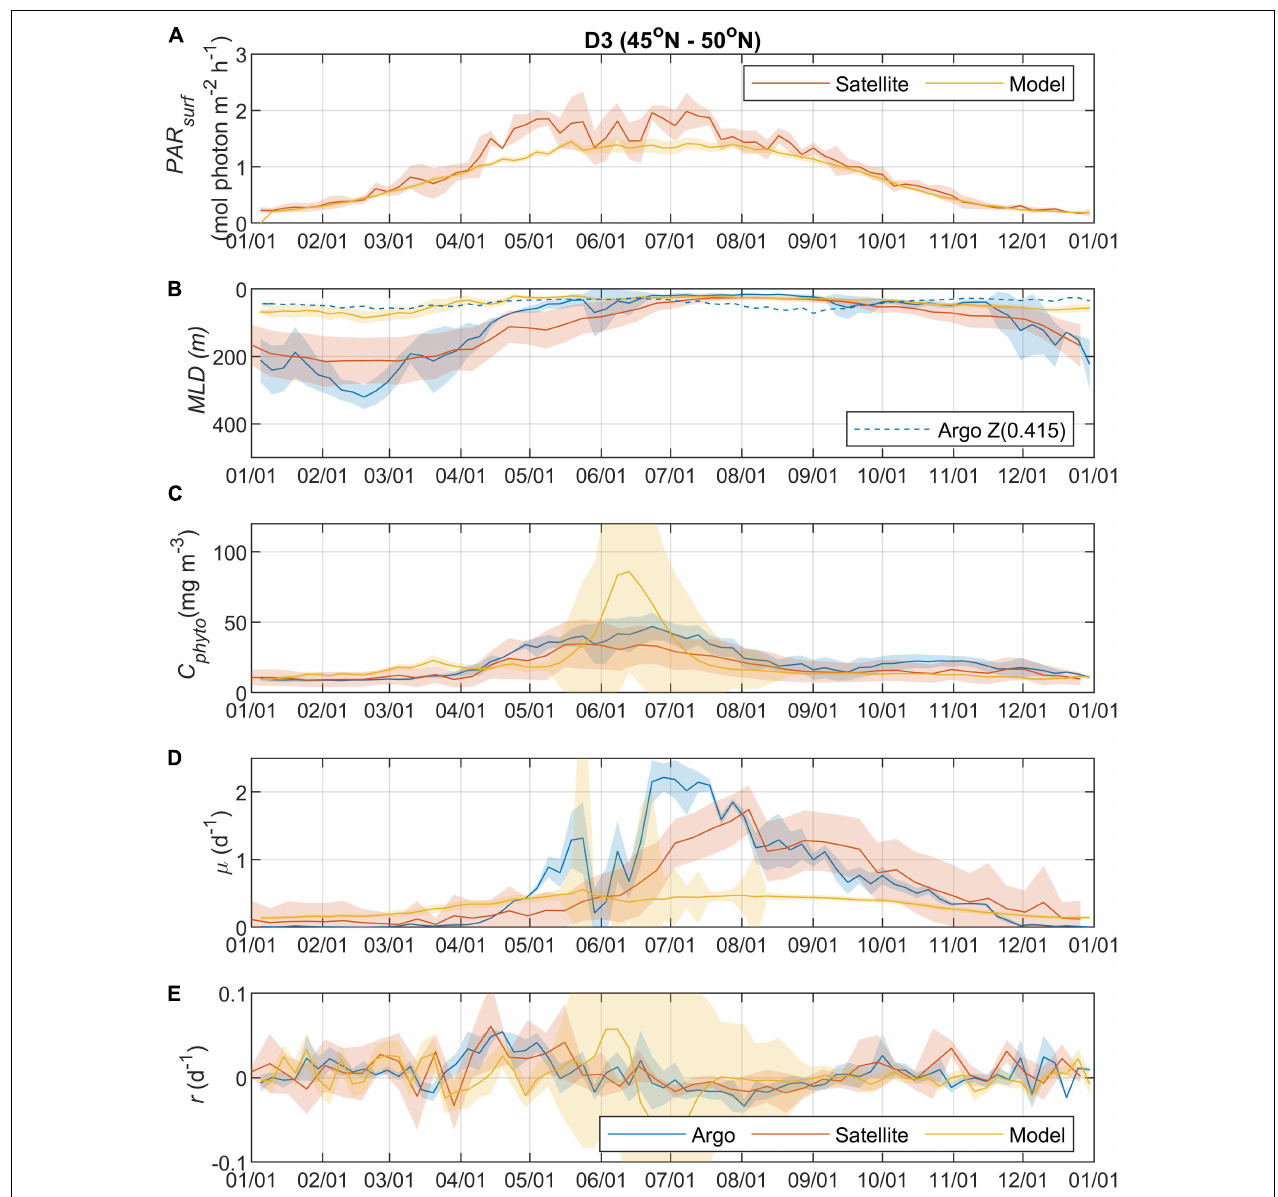
FIGURE 4 | Seasonal climatologies of (A) PAR surf , (B) MLD , (C) C phyto , (D) µ , and (E) r from Argo floats, satellite, and model simulation for region D3. See the caption of Figure 2 for